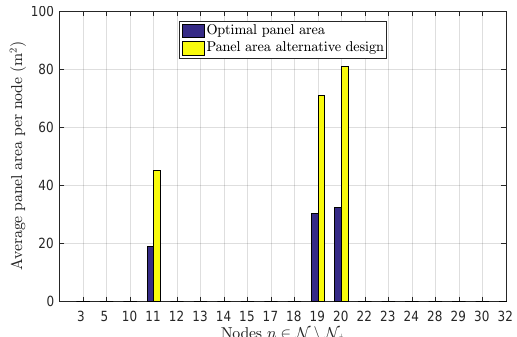
Figure 11. Comparison of average panel area per node.